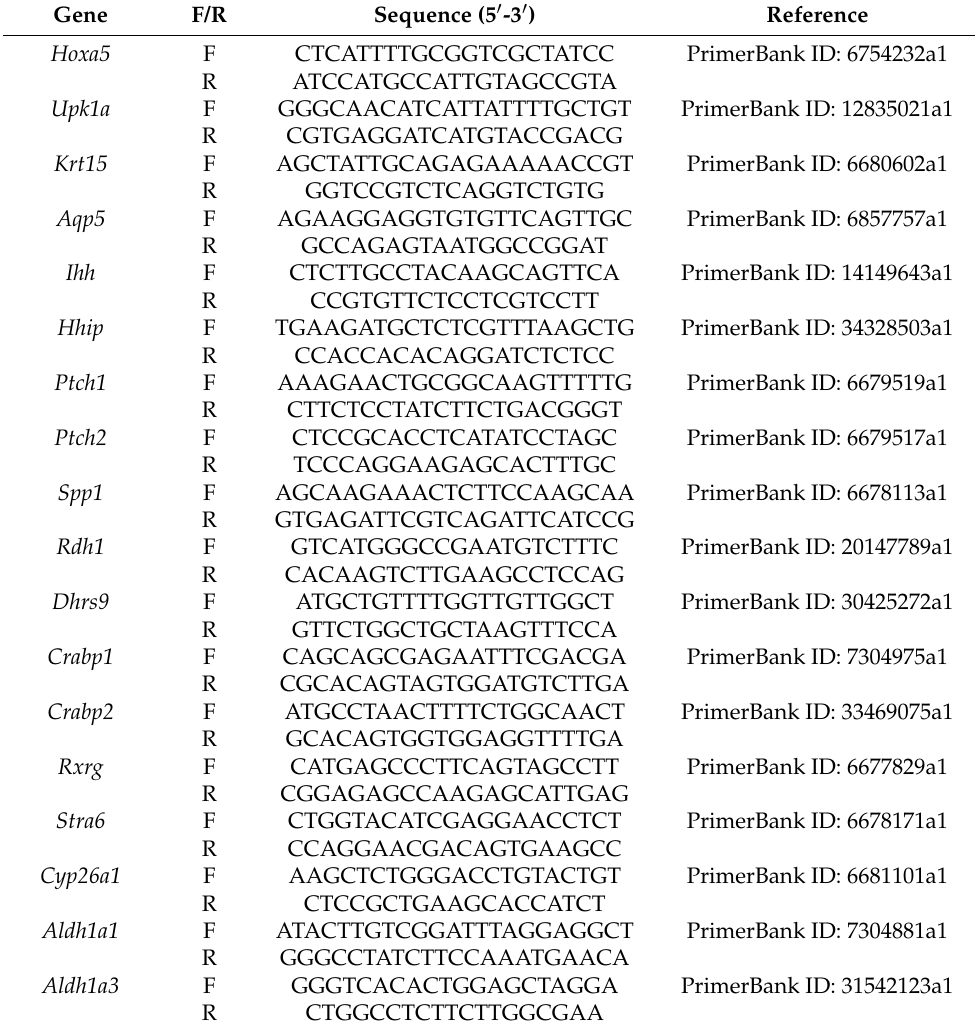
Table 2. qRT-PCR